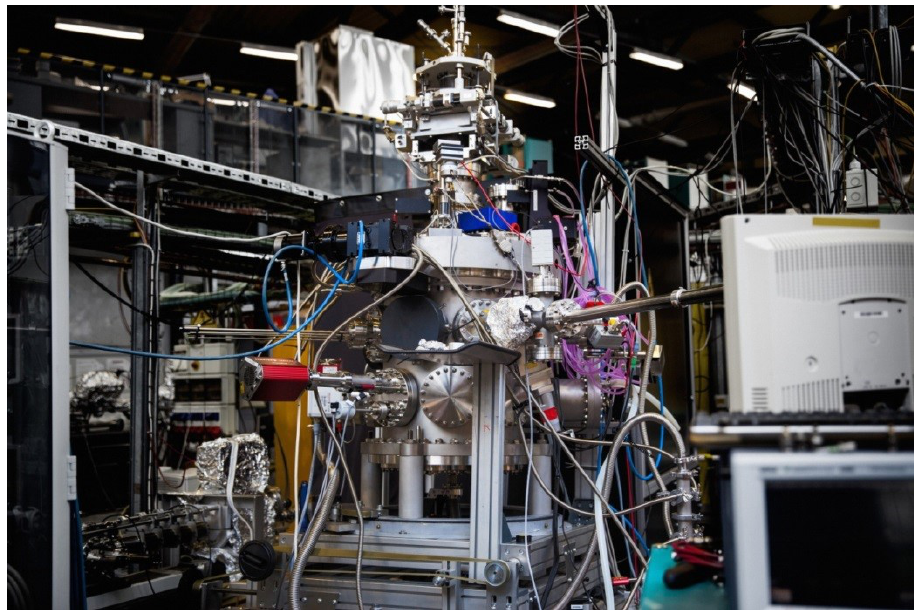
Figure 4: View of the FEMTOSPEX Scattering